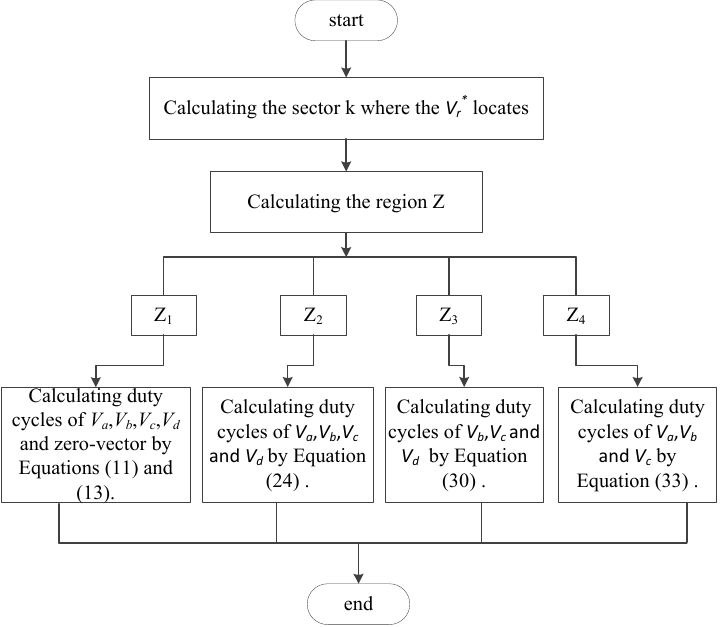
Figure 5. Flowchart for the proposed HSOS strategy.